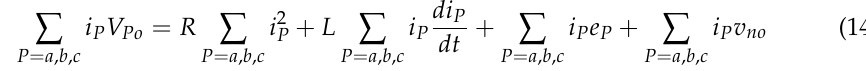
By adding (13) for phases a , b , and c , we obtain: